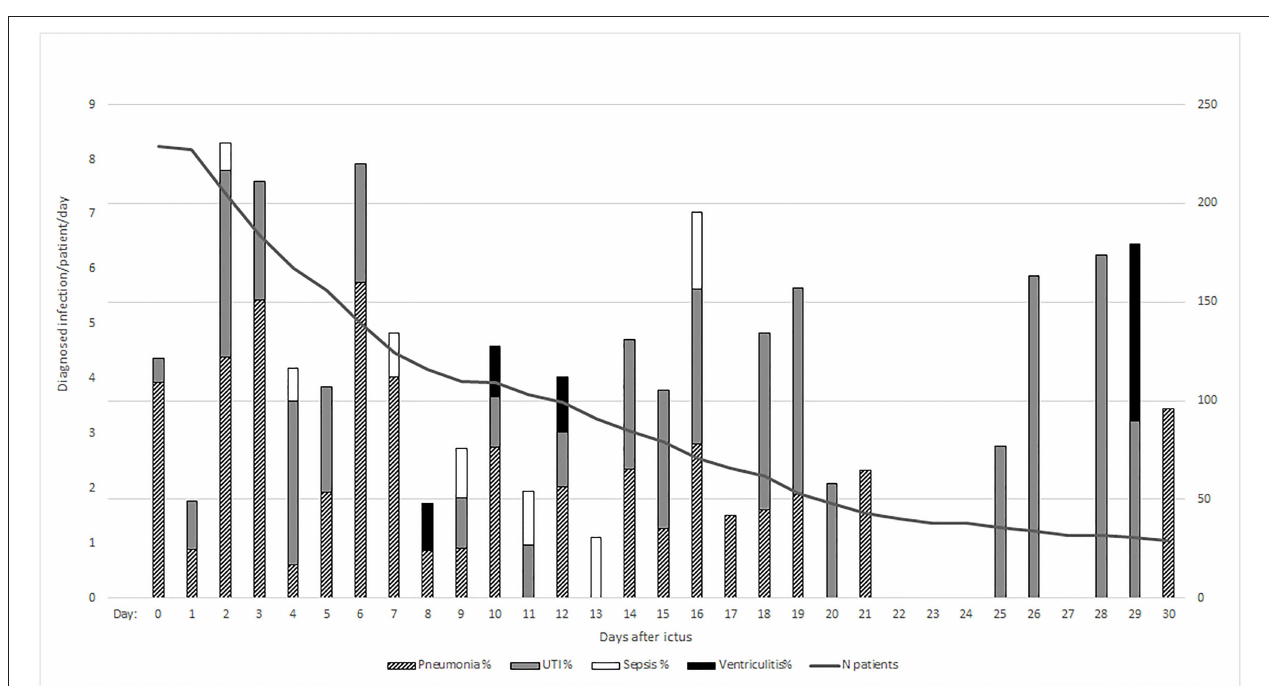
FIGURE 3 | Represents relative prevalence of diagnosed infections per day/per patient to account for patients still admitted to the ICU. The absolute number of infections per day was divided by the number of patients per day. N patients = number of patients.